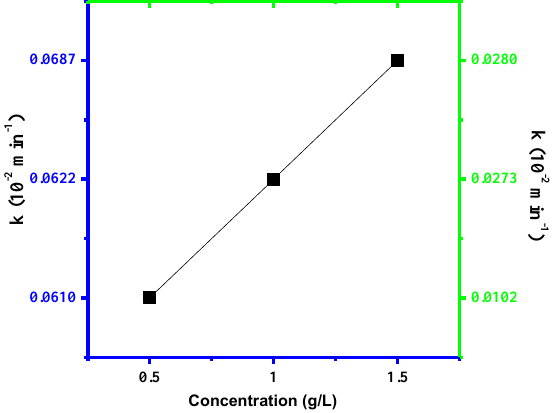
Figure 7. Rate constants of Remazol Blue discoloration in function of the photoactive materials concentration.